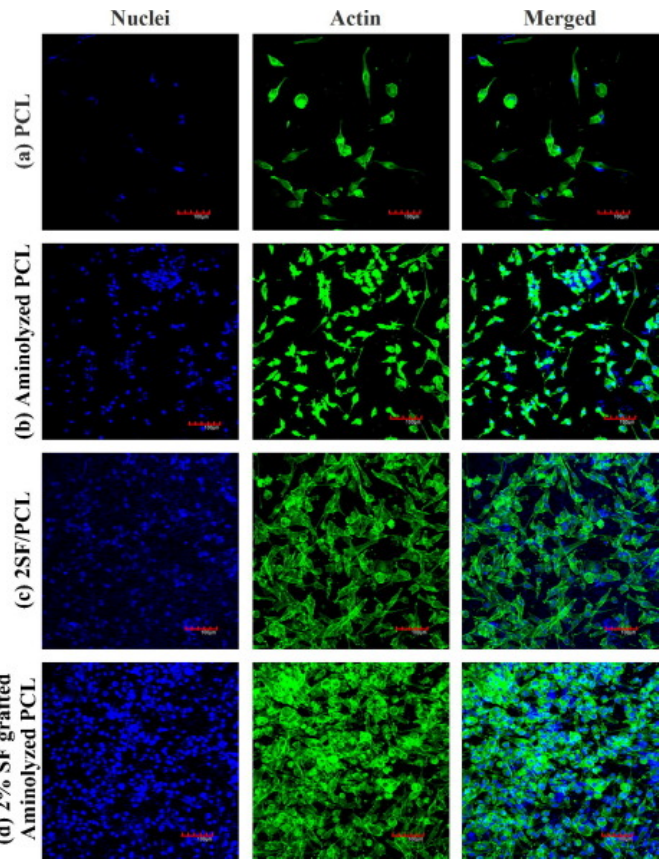
Figure 4. The cytoskeletal actin organization and distribution of MG-63 cells grown on ( a ) unmodified PCL nanofibers, ( b ) PCL after aminolysis, ( c ) PCL blended with silk fibroin (SF), and ( d ) aminolyzed PCL after subsequent SF immobilization at day-point 7. Reprinted from Eur. Polym. J. 2015, 71, 490–509 with permission from Elsevier